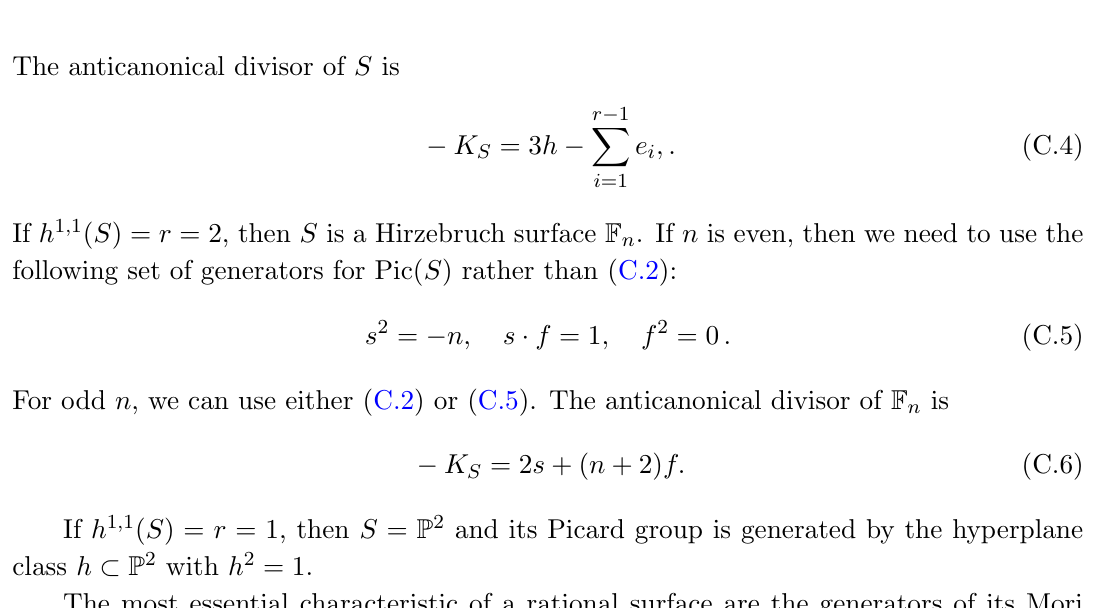
Figure 20 . The blow-ups from the Hirzebruch surface F 1 to a generalized del Pezzo surface gdP 2 of type A 1 and a del Pezzo surface dP 2 . The circle denotes the points to be blown up on F 1 . Hence gdP 2 and dP 2 are related by a